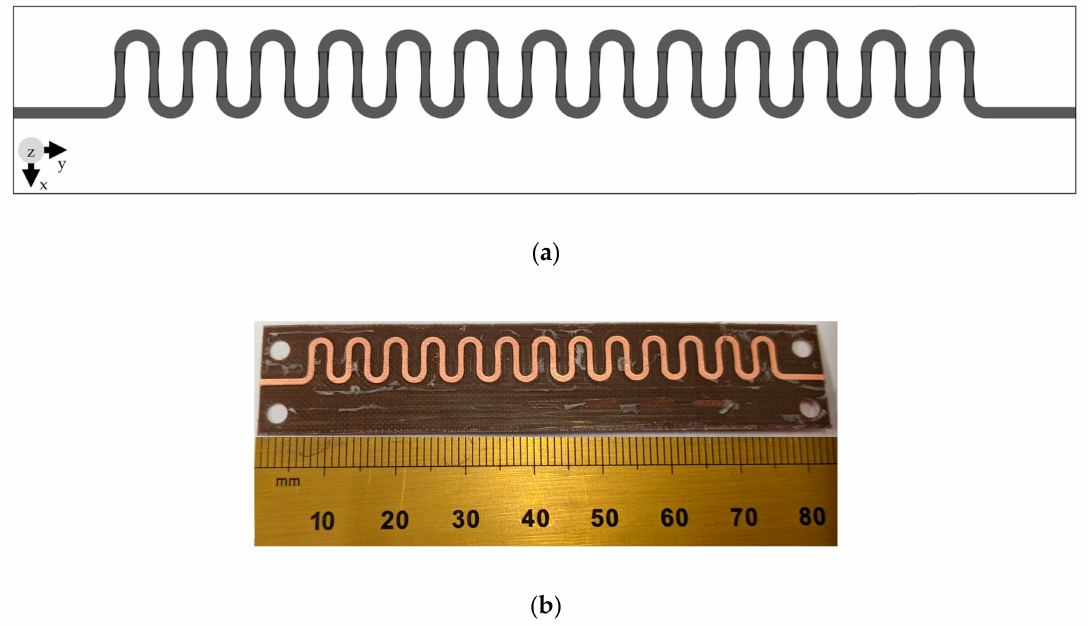
Figure 3. Top view of the proposed periodic 13 unit-cell antenna fabricated on 0.254 mm thick grounded Arlon DiClad 880 substrate. ( a ) Geometry. ( b )